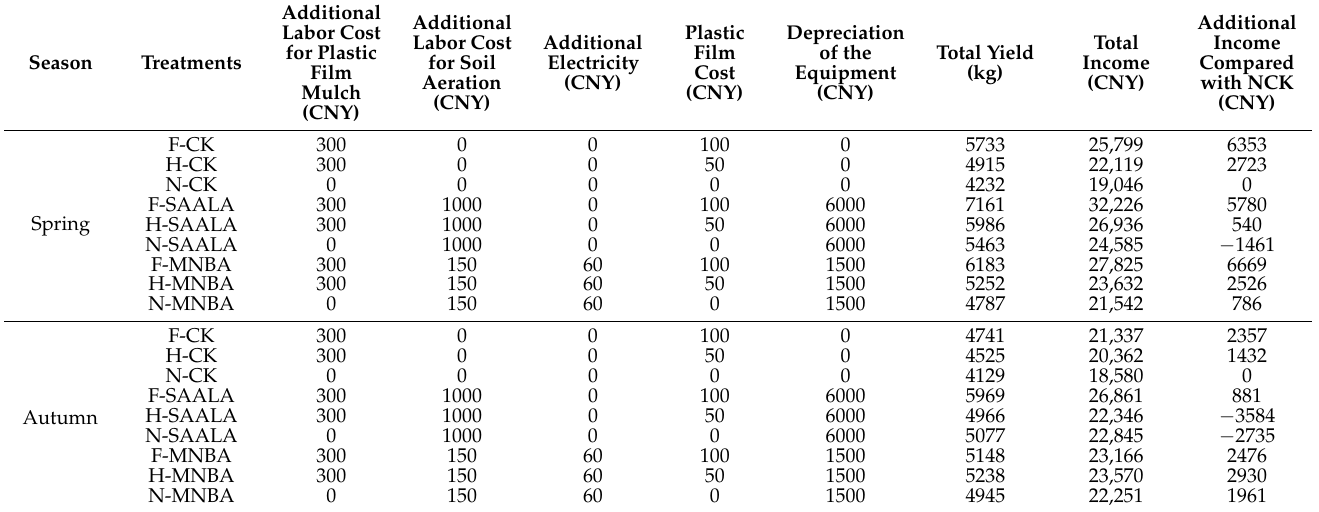
Table 7. Economic analysis of soil aeration and plastic film mulch treatments in a 100-m-long